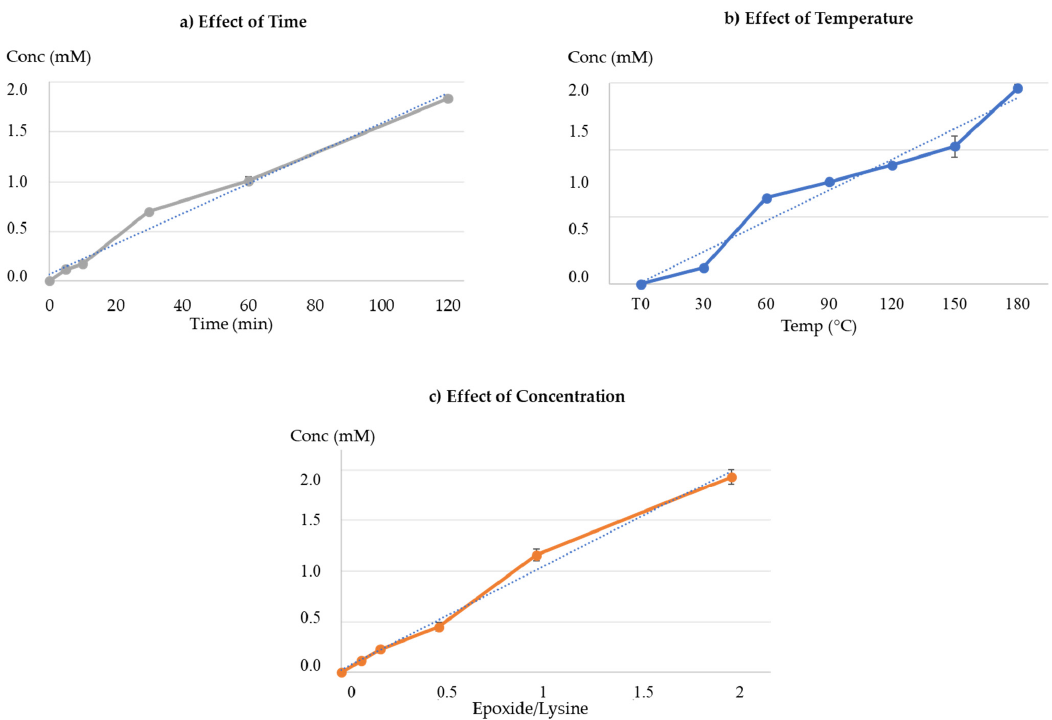
Figure 9. Kinetic studies: evolution of the reaction product levels from the reaction between N α -benzoylglycyl- l -lysine and cholesterol 5 α ,6 α -epoxide. ( a ) Effect of time on the reaction between cholesterol 5 α ,6 α -epoxide and the ε -amino-group of lysine (incubation temperature: 180 °C). ( b ) Effect of temperature on the reaction between cholesterol 5 α ,6 α -epoxide and the ε -amino-group of lysine (incubation time:120 min). T0: before reaction. ( c ) Effect of oxysterol concentration (incubation at 180 °C for 120 min). Epoxide/Lysine = concentration of cholesterol 5 α ,6 α -epoxide/concentration of N α -benzoylglycyl- L -lysine.